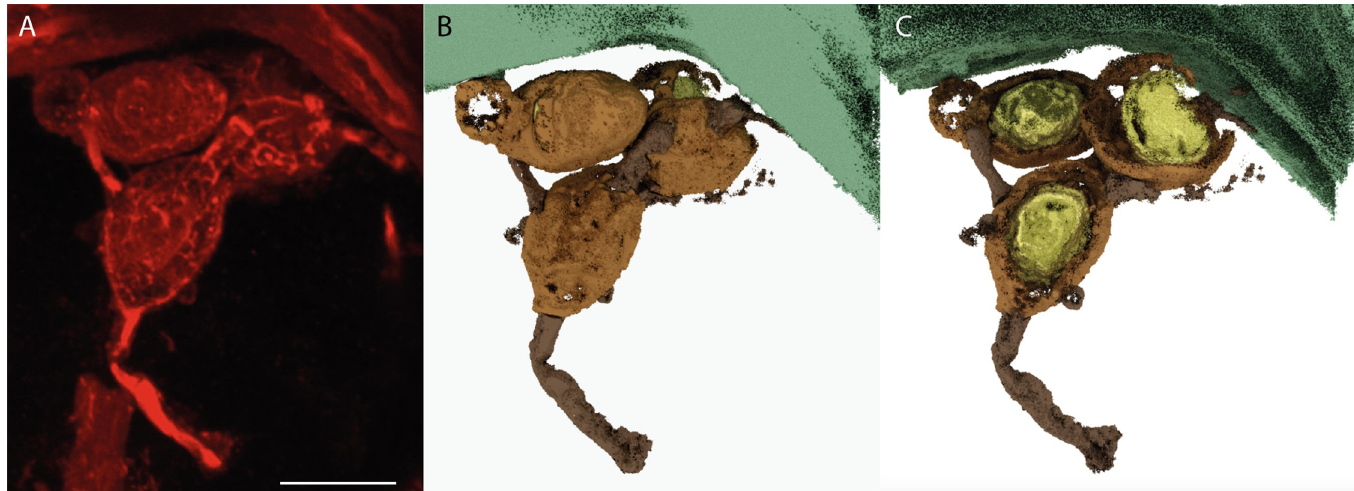
Fig 5. Three-dimensional reconstruction of oogonium-antheridia complexes of Oochytrium lepidodendri using confocal scanning laser microscopy (A) and CSLM images processed (B, C). Three antheridia are attached to one of the oogonia and possibly two others in a degraded stage (S2 Movie). Single oospore visible in the oogonium (C). Oogonium in light brown, antheridia in dark brown (B, C), oosphere in yellow (C). Scale bar represents 8.5 μ m in (A). MNHN.F.45876.0 n˚1146 Renault collection.